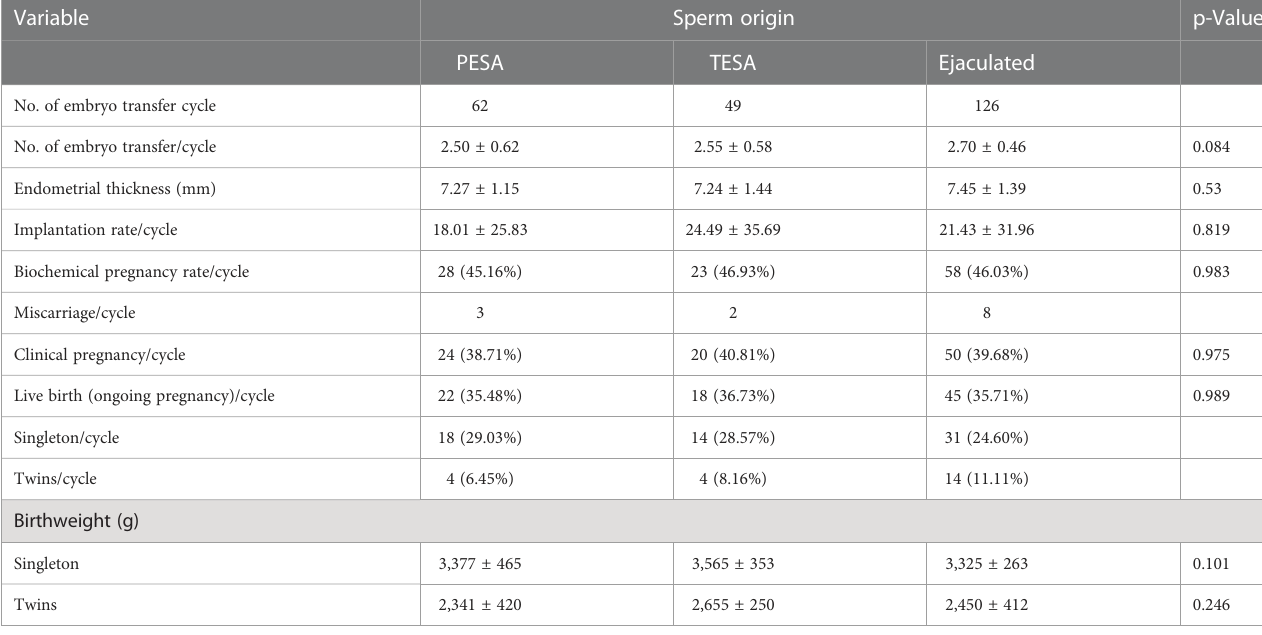
TABLE 2 Comparison of clinical and obstetric outcomes based on different sperm sources in IVM – ICSI cycle.